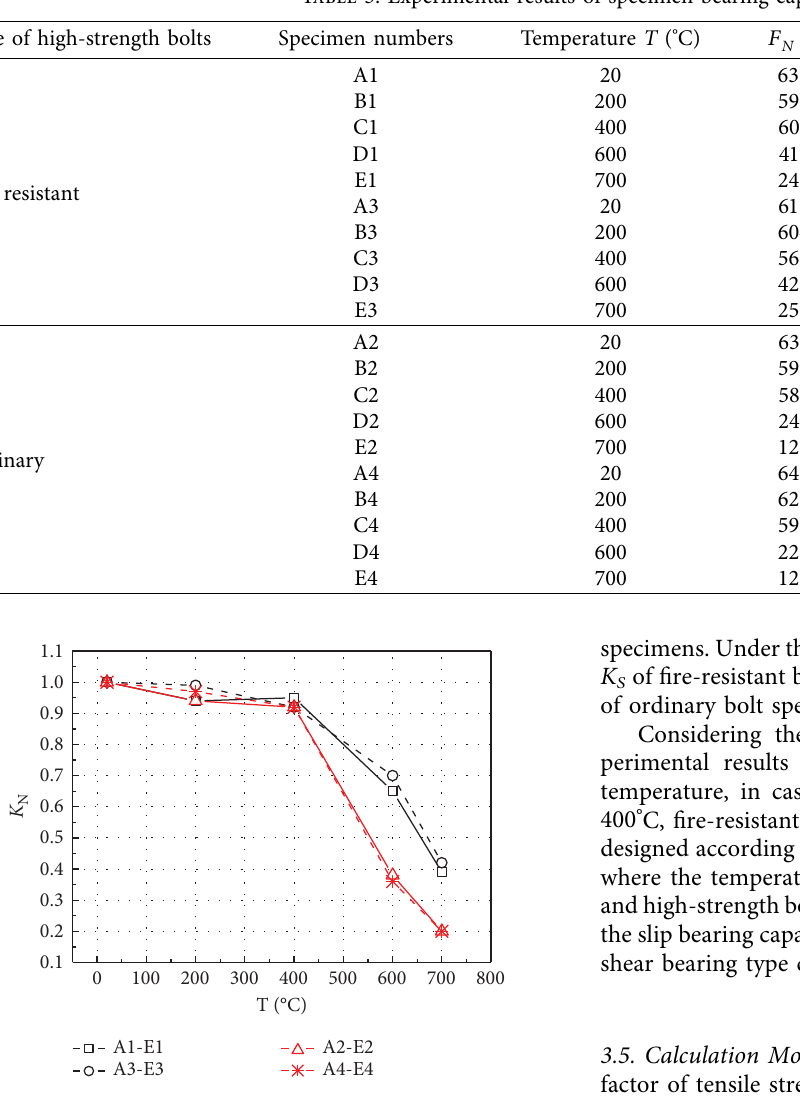
ftting. Te degrees of ftting of equation (2) are R � 0.842 (20 ° C ≤ T < 400 ° C) and R � 0.976 (400 ° C ≤ T < 700 ° C), re- spectively. Te degrees of ftting of equation (3) are R � 0.912